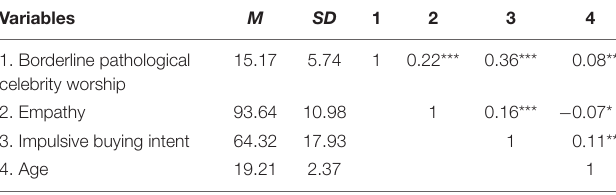
TABLE 1 | Descriptive statistics and inter-correlations between